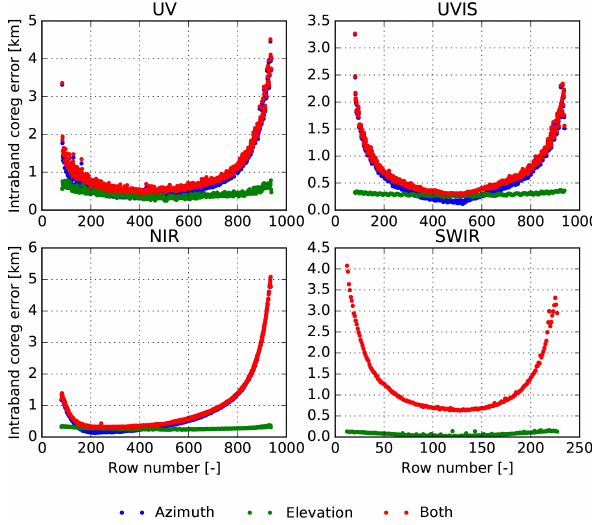
Figure 32. Intra-band co-registration error as distance on the sur- face of the Earth (km) versus row number (spatial direction), for all detectors. For each row, the maximum difference between the ele- vation (green), azimuth (blue), and the combination of elevation and azimuth (red) is shown for any pixel pair in that